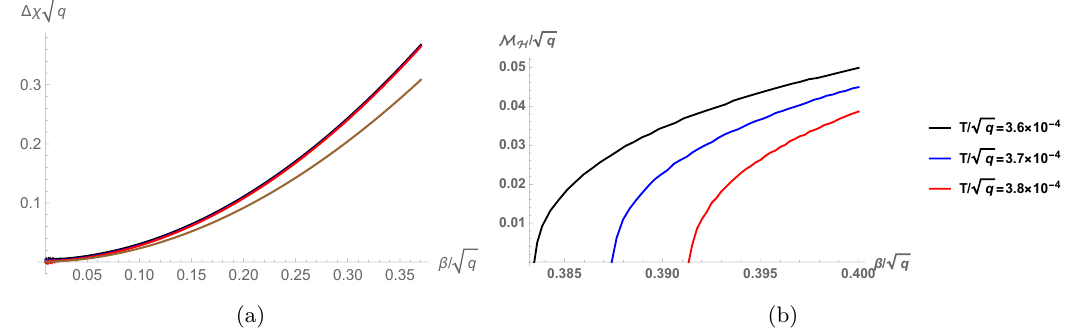
Figure 7 . (a) shows the susceptibility (3.16) in the WL phase. To see increasing behavior clearly, we subtract the reference value so the presented curves for ∆ χ ≡ χ − χ β =0 . The brown curve √ q = 1 . 5 × 10 − 2 ) added to show the coincidence of the other curves is just from the small pa- ( T/ rameter differences. (b) shows the spontaneous magnetization in the HMC phase. The spontaneous magnetization begins to appear at certain critical impurity densities and grows with increasing im-